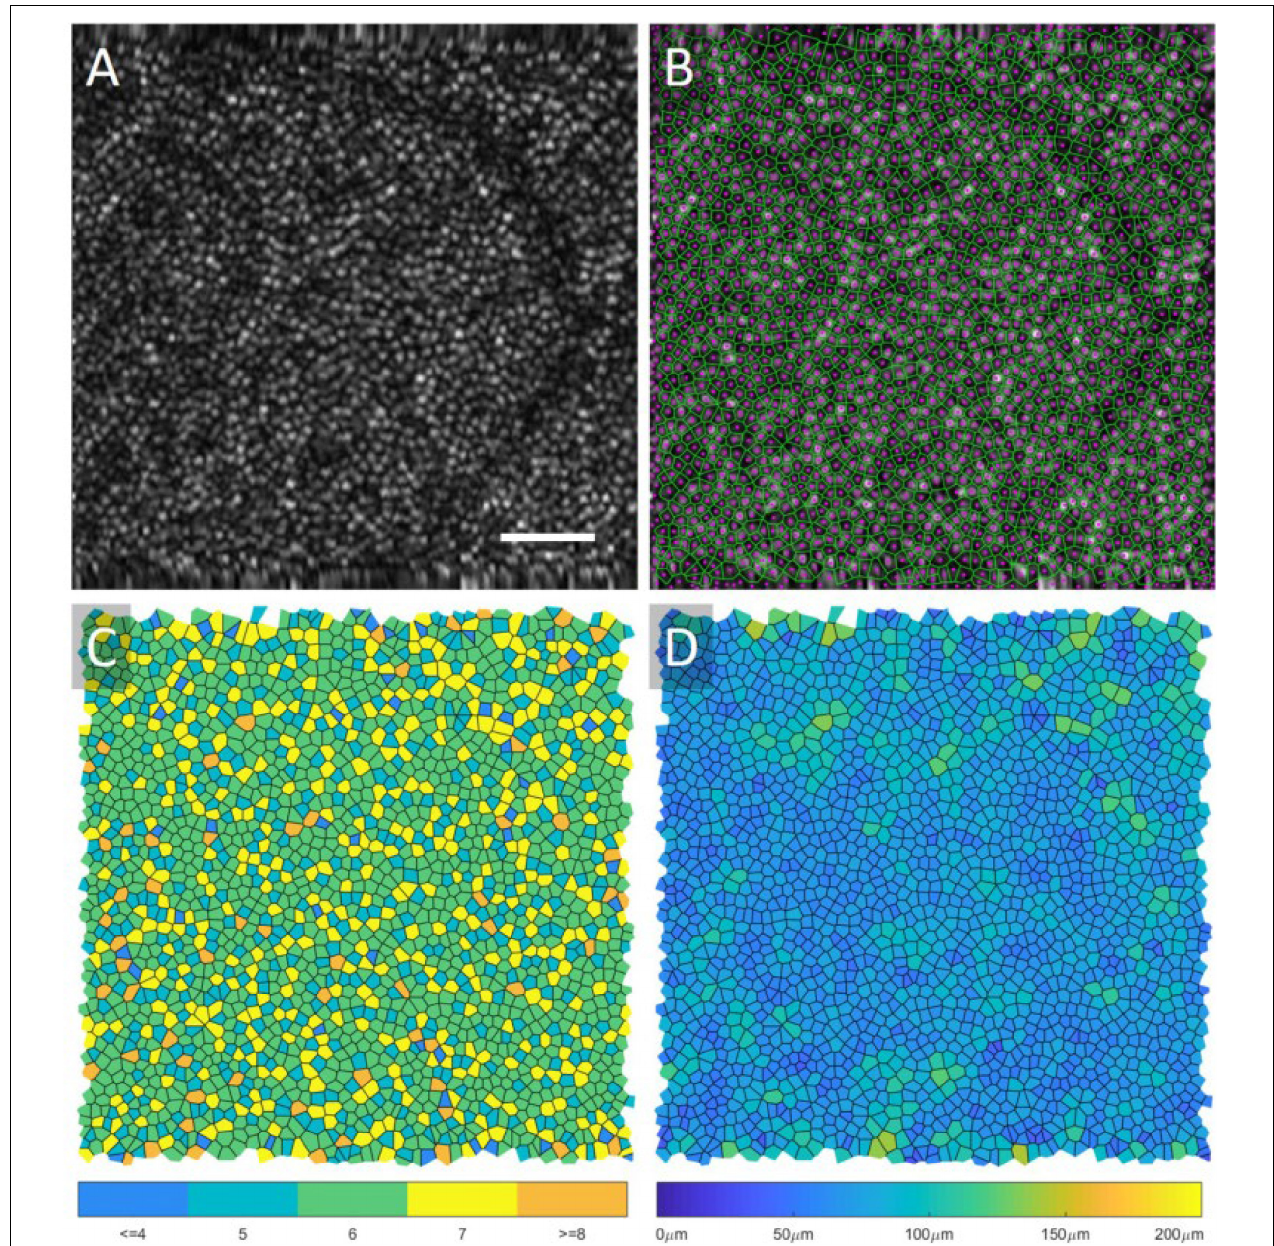
FIGURE 6 | Voronoi analysis of photoreceptors from AO-OCT. An original AO-OCT image taken at ∼ 6.5 ◦ retinal eccentricity is displayed in (A) , and the center of the cones (magenta) and the Voronoi map (green) is overlaid onto the image in (B) . In (C) , the Voronoi cells are shaded based on the number of neighbors, and, in (D) , the cells are shaded based on their area. A scale bar, 50 µ m. This figure was reprinted from Heisler et al. (508) with